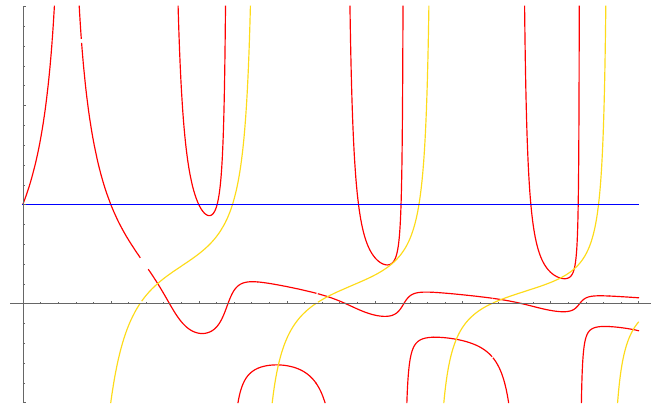
Figure 7 . The eigenvalues of the kernels of the 4-point functions in the model (3.56). The yellow curves represent the diagonal k 11 eigenvalues, while the red curves are from diagonalizing the matrix of k 22 , k 23 , k 32 and k 33